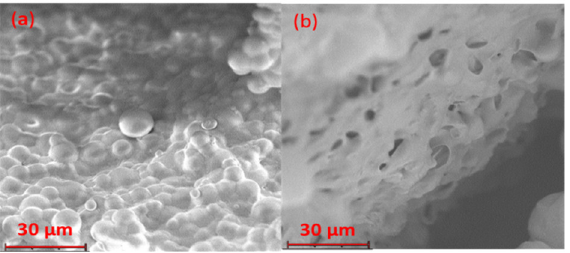
Figure 7. SEM micrographs of microparticle exposed to sintering obtained at 2350× magnification: ( a ) aRB-PCL sintered disk; ( b ) bRB-PCL sintered disk.